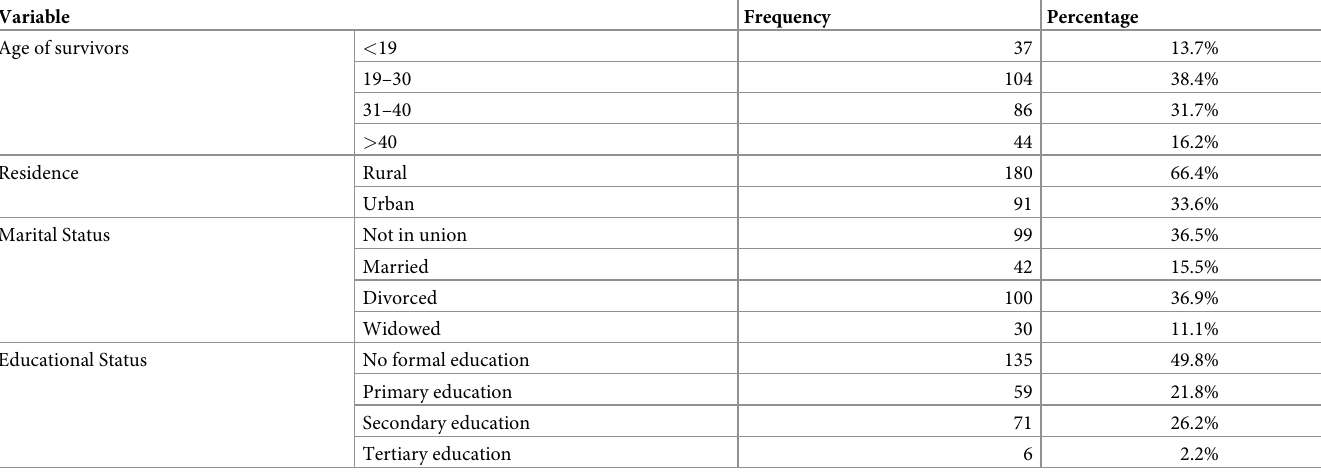
Table 1. Socio-demographic characteristics of rape among survivors during armed conflicts in Northeast Ethiopia, 2022 (n = 271).